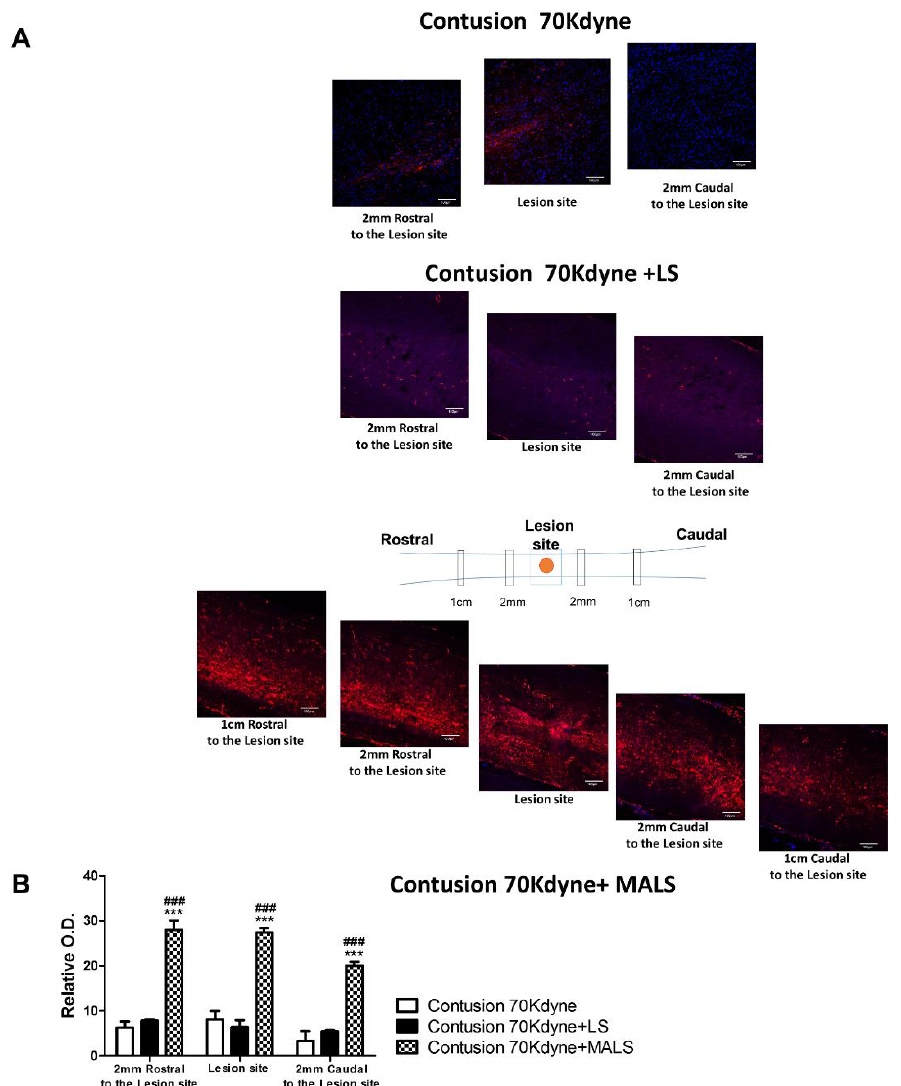
Figure 9. In vivo axonal transport recovery. ( A ) Qualitative images of anterograde axonal transport 35 days after contusion in lesioned non-treated animals (LES), or lesioned animals treated with LS and MALS. As described in Materials and Methods, Fluoro-Ruby was injected at T6/T7 25 days after lesioning and animal sacrificed 10 days later. Schematic reconstruction of spinal cord longitudinal sections of lesioned, lesioned + LS, and lesioned + MALS treated animals. Nuclei were stained with DAPI (blue). ( B ) The graph shows the quantification of fluorescence 2 mm rostral and caudal to the lesion and at the epicenter of the lesion. Quantification was performed in three animals per group 35 days after lesion. Statistical differences were determined by means of one-way ANOVA test followed by Bonferroni’s post-test. *** p < 0.001 vs. LES; ### p < 0.001 vs. LS.